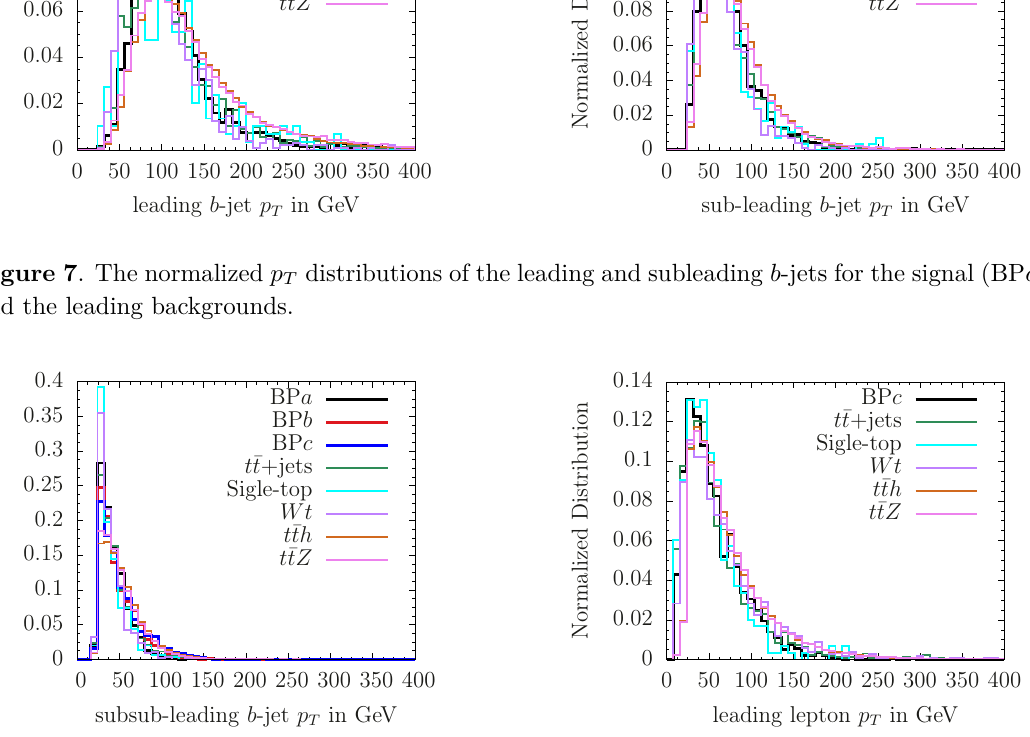
Figure 8 . The normalized p T distributions of the subsubleading b -jet (right) and leading lepton (left) for the signal (BP c ) and leading